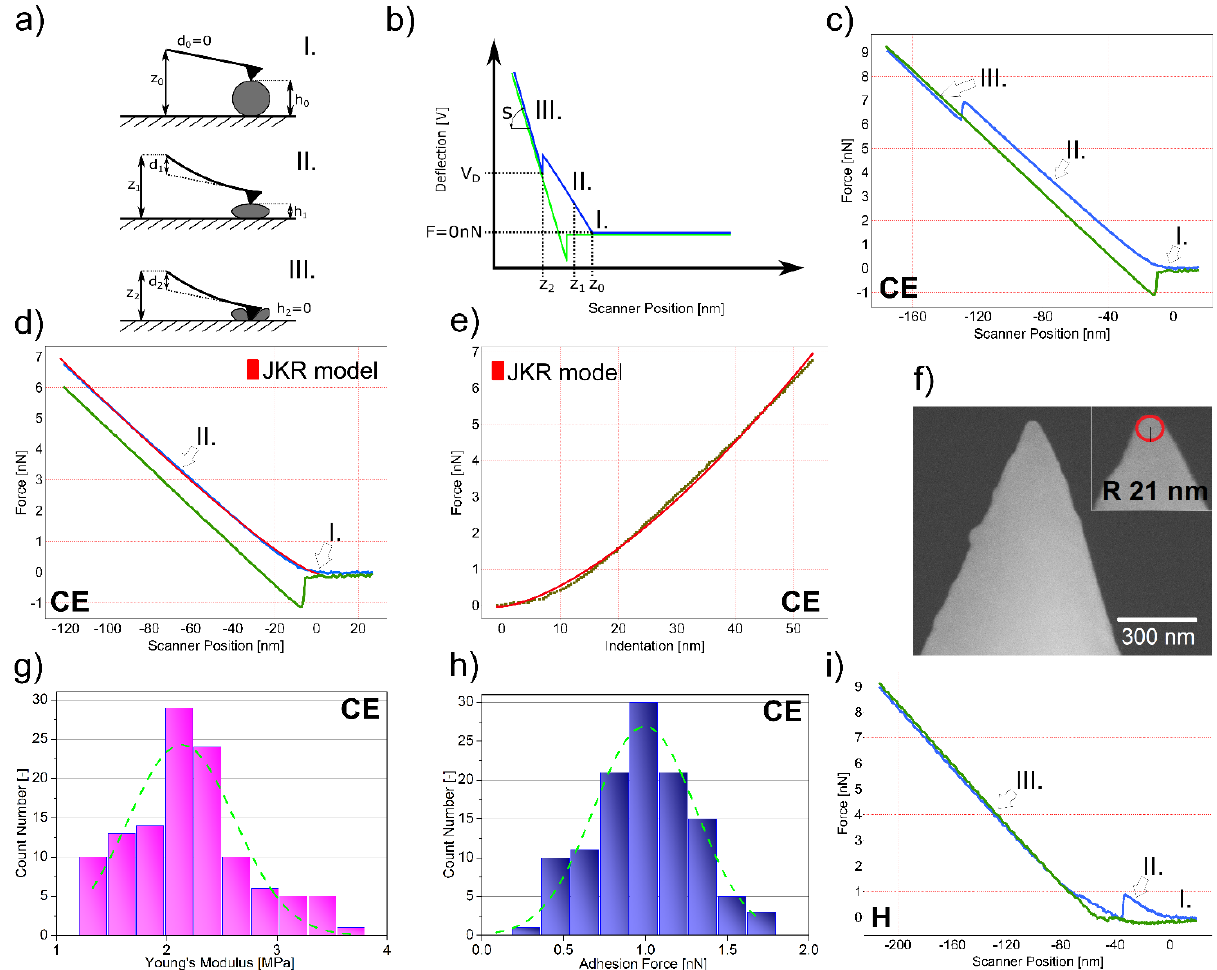
Figure 5 : Quantitative analysis of nanomechanical properties of SUV by FS: (a,b) illustrative scheme of the force spectroscopy experiment – force curve and indentation (I. – physical contact between AFM tip and surface of a vesicle, II. – indentation of a vesicle, III. – indentation of the mica substrate; symbols: z – scanner position, d – cantilever deflection, V – cantilever deflection signal, h – height of vesicle, S – D sensitivity, F – force); (c,d) typical approach (blue) – retraction (green) force curve recorded on a CE vesicle with calculated force [nN]; (d,e) the Johnson-Kendall-Roberts (JKR, red curve) model fitted to typical CE data region II. – force curve (d) and corresponding force-indentation profile (e); (f) scanning electron micrograph of Bruker DNP B tip after the experiment (cantilever no. 1, inset: radius R of the tip); (g,h) calculated Young’s modulus and adhesion force histograms for CE specimen (green striated curve – fitted Gauss distribution profile); (i) typical approach (blue) – retraction (green) force curve recorded on a H sample depicts indented lipid bilayer patch (region